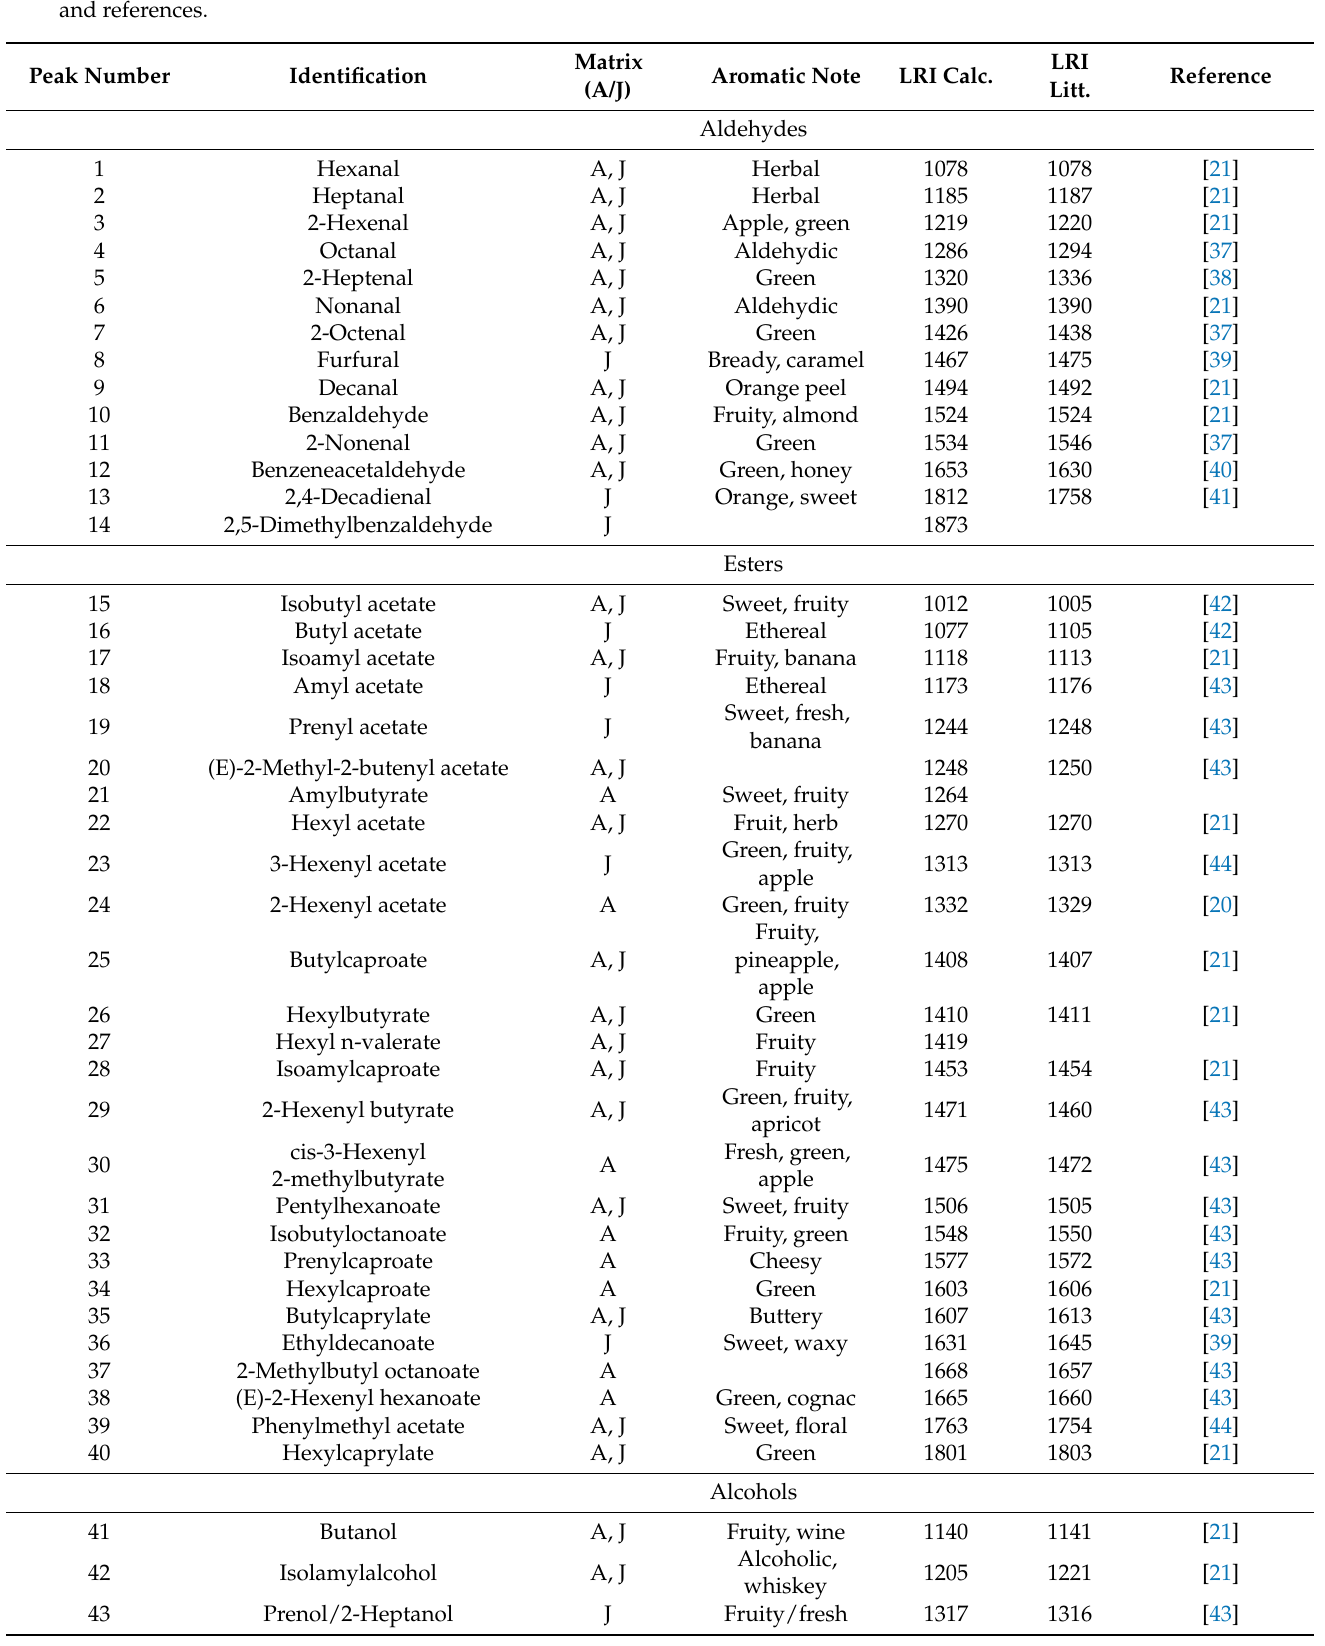
Table 2. Volatile compounds of apple fruit and juice with the corresponding aromatic notes, calculated and tabulated LRIs, and